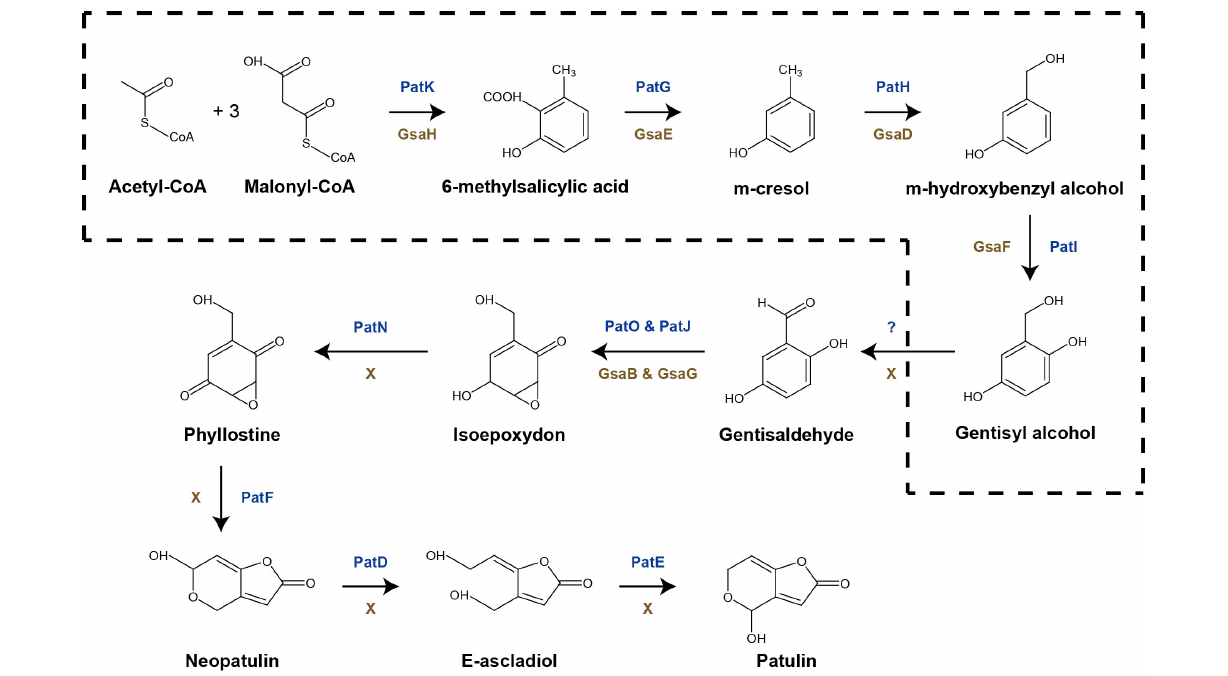
Frontiers in Marine Science |